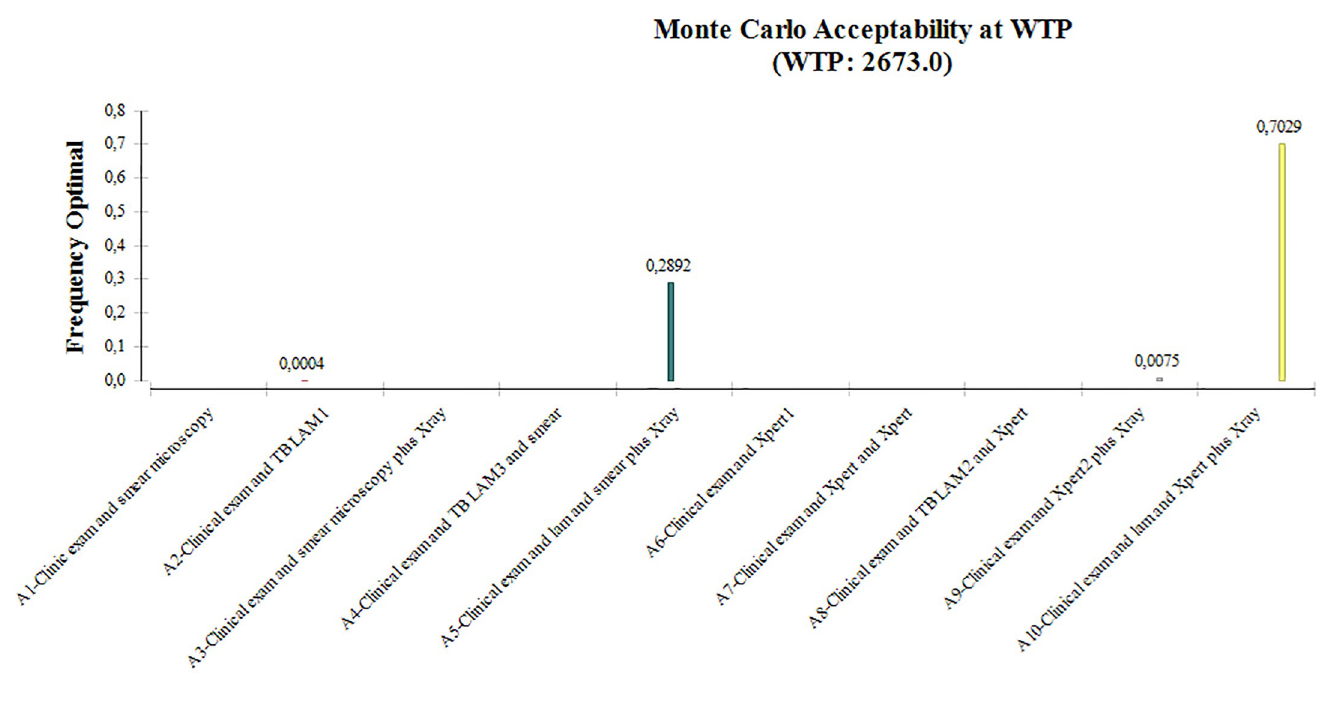
Fig 3. Probability of cost-effectiveness of each algorithm according to the society’s Willingness To Pay ( € 2,673).